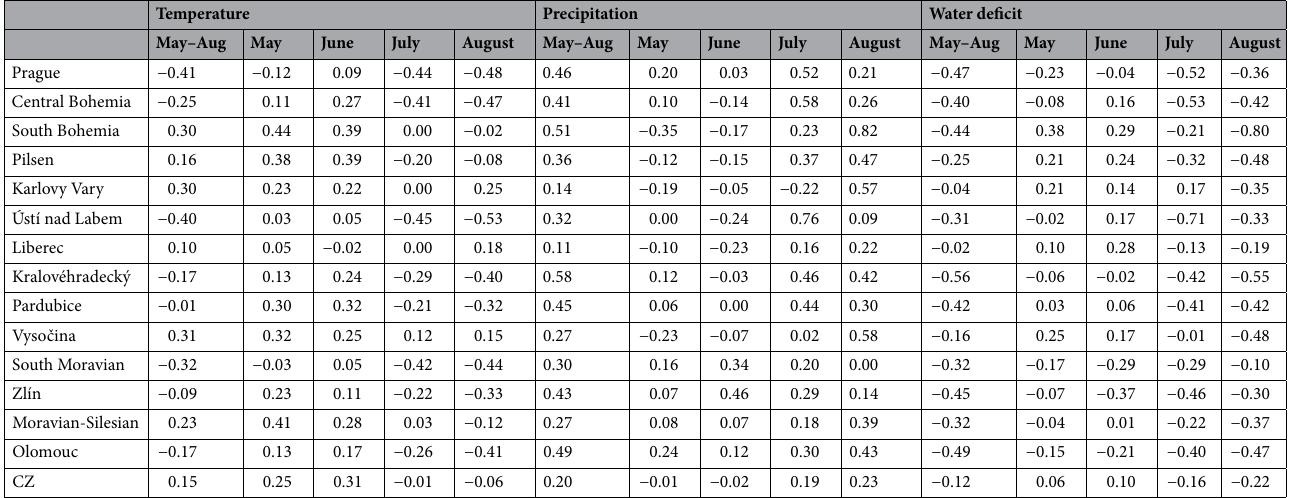
Table 4. Pearson correlation between profit with temperature, precipitation, and water deficit.